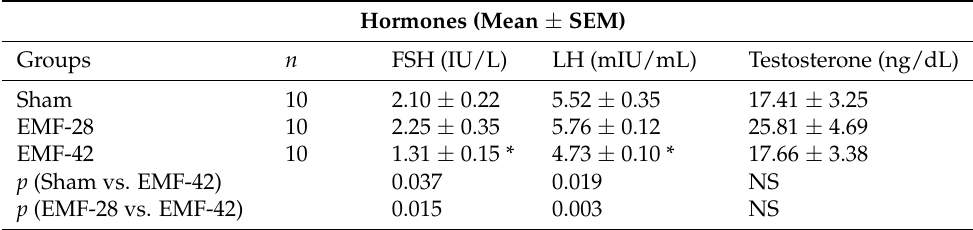
Table 2. Sex hormone levels of male rat pups.